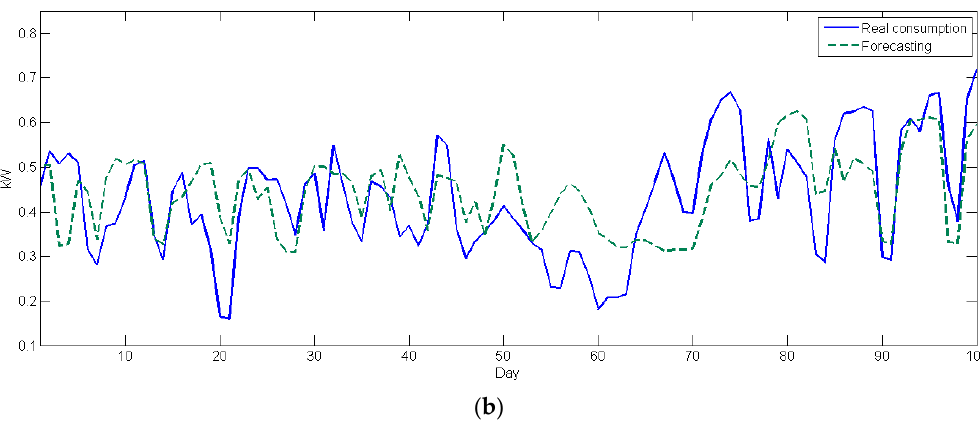
Figure 12. Best prediction ( a ) and worst prediction ( b ) of the next 100 days for the normalized data of energy consumption of Building 5 using NARX model.